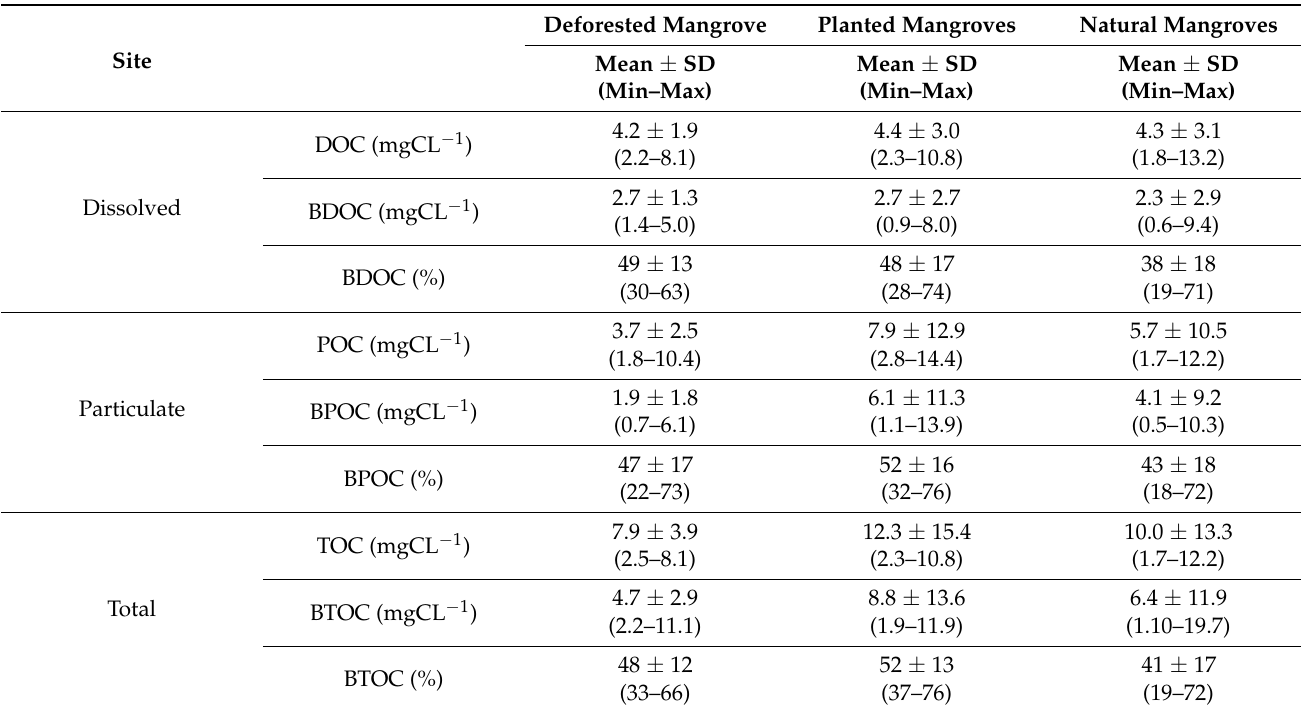
Table 2. The range of organic carbon ( ± standard error), the respective concentration and percentage of biodegradable. The time that has been set for the experiment is 40